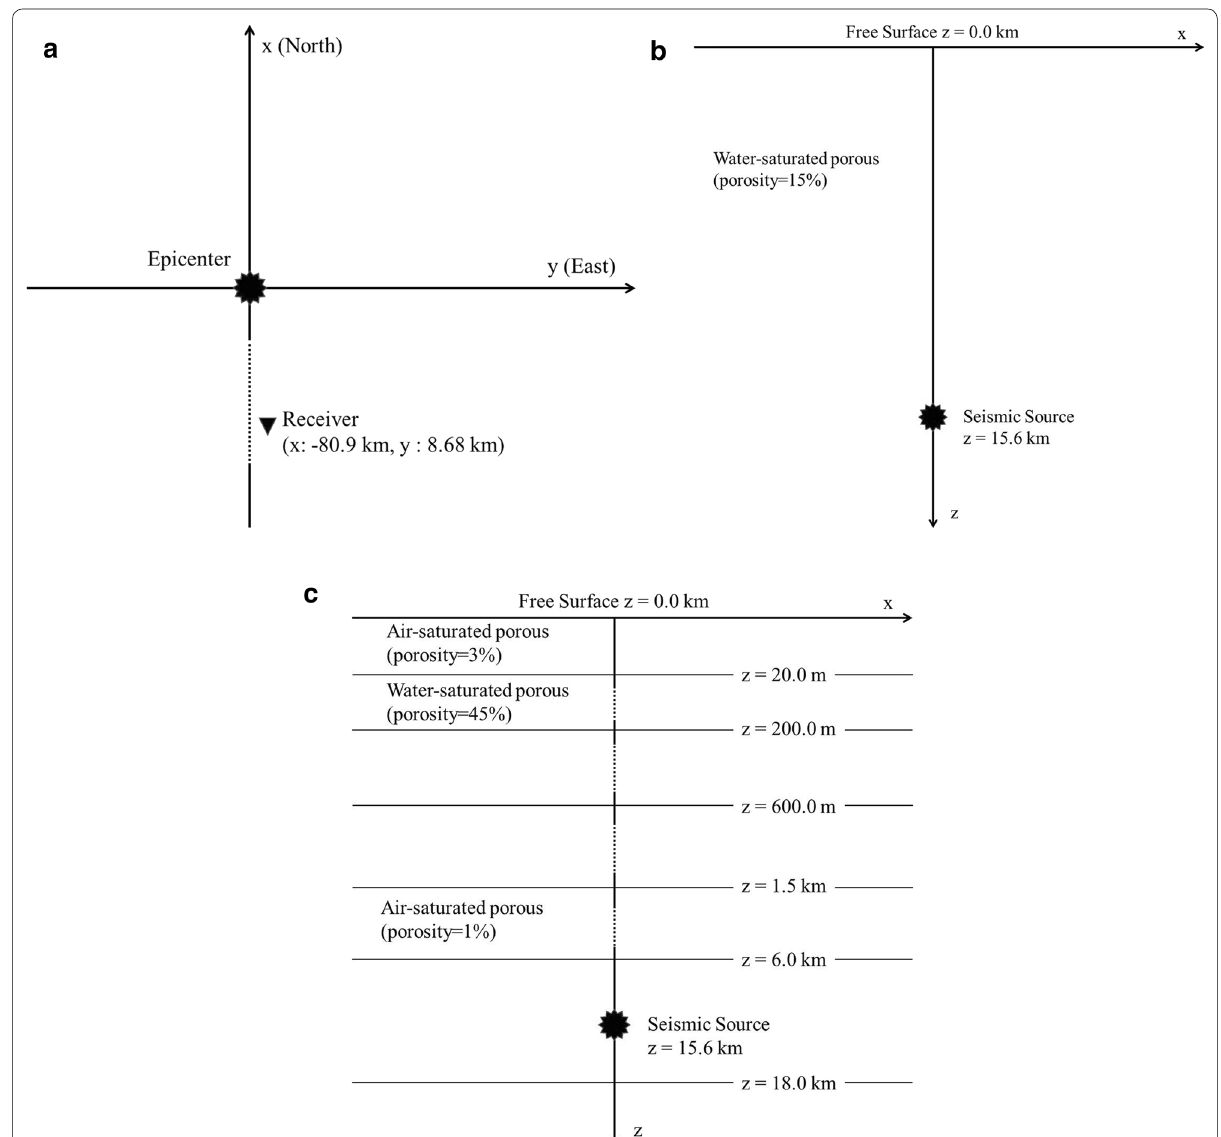
Fig. 3 Source–receiver configuration and models utilized in the numerical section. a Bird view of the epicenter and receiver. b The water‑saturated half‑space porous model. c The seven‑layer half‑space